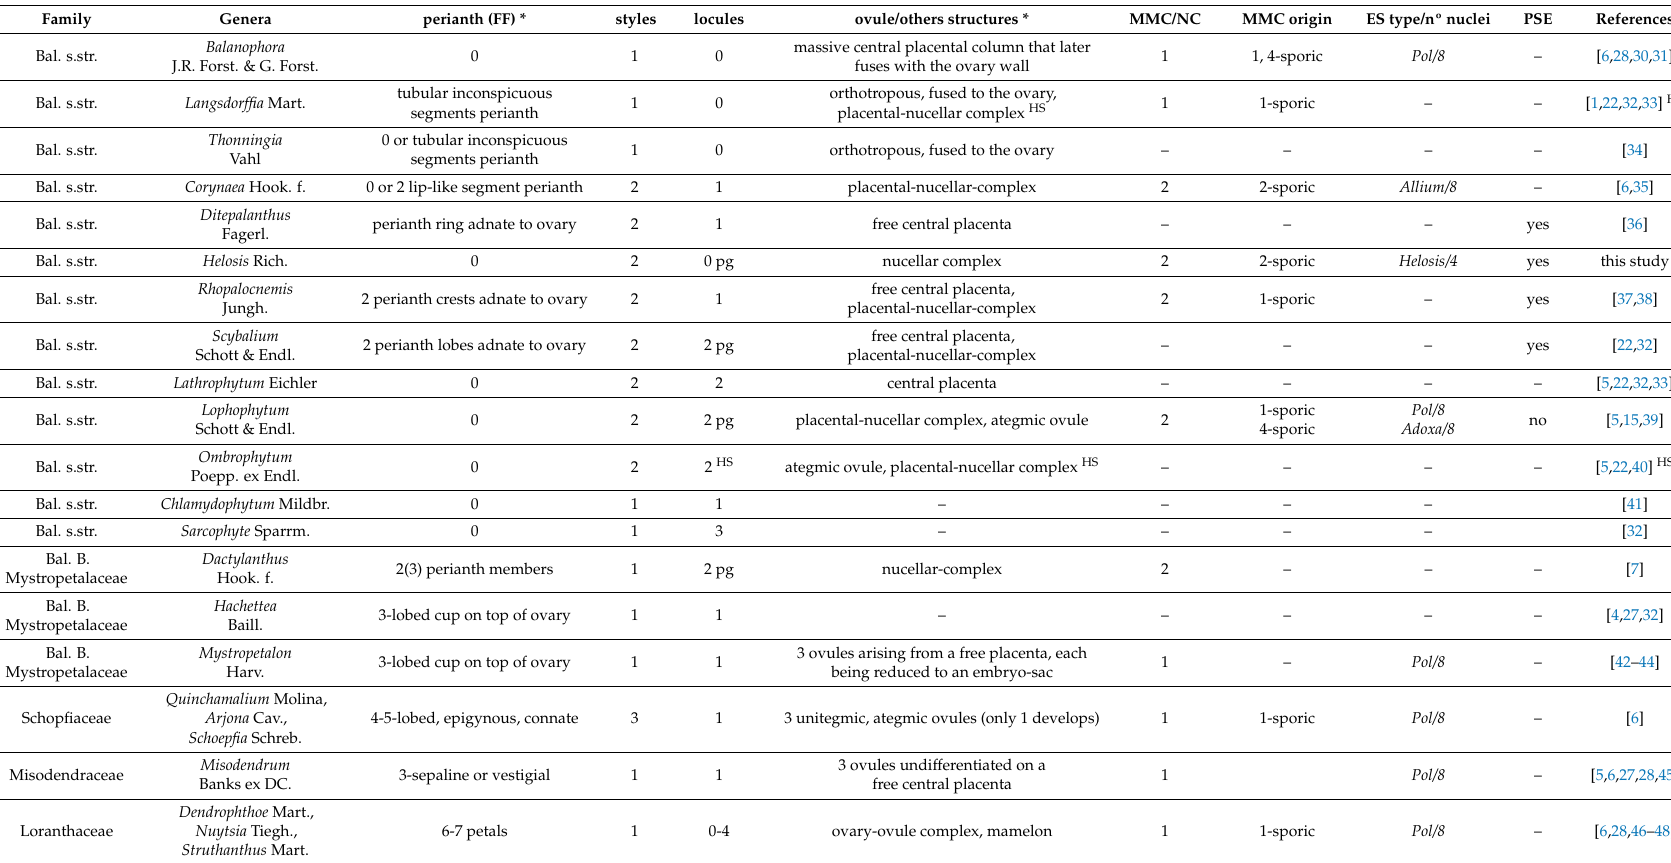
Table 1. Summary of floral characteristics of Balanophoraceae s.l. (Bal. clade A o sensu stricto and clade B or Mystropetalaceae) and other related families according to the phylogeny proposed by Su et al.